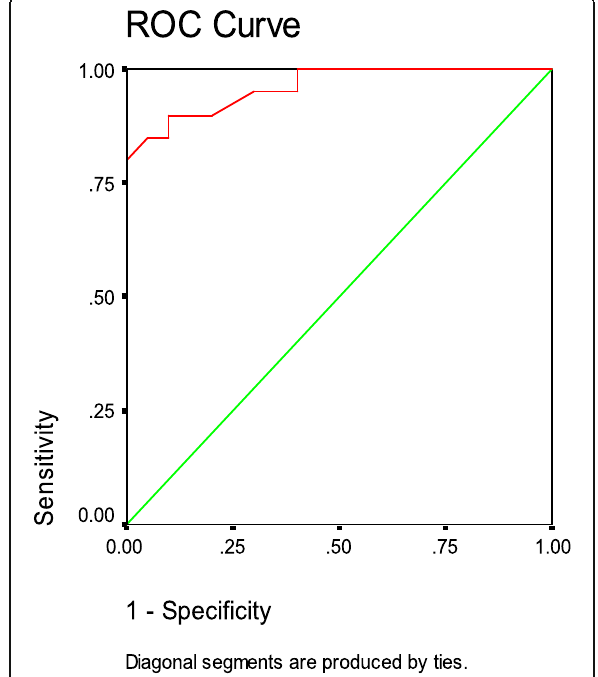
Fig. 6 Receiver operating characteristic (ROC) curve of the ADC values for differentiation between benign and malignant solid neck masses. The area under the curve (AUC) was 0.946